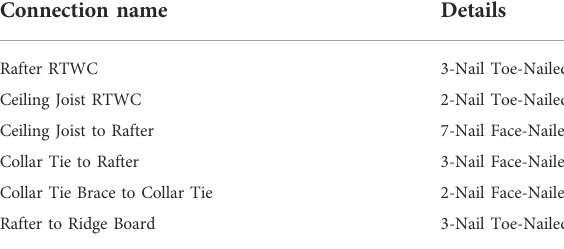
TABLE 4 Connections used in the fi rst model iteration, following NBCC